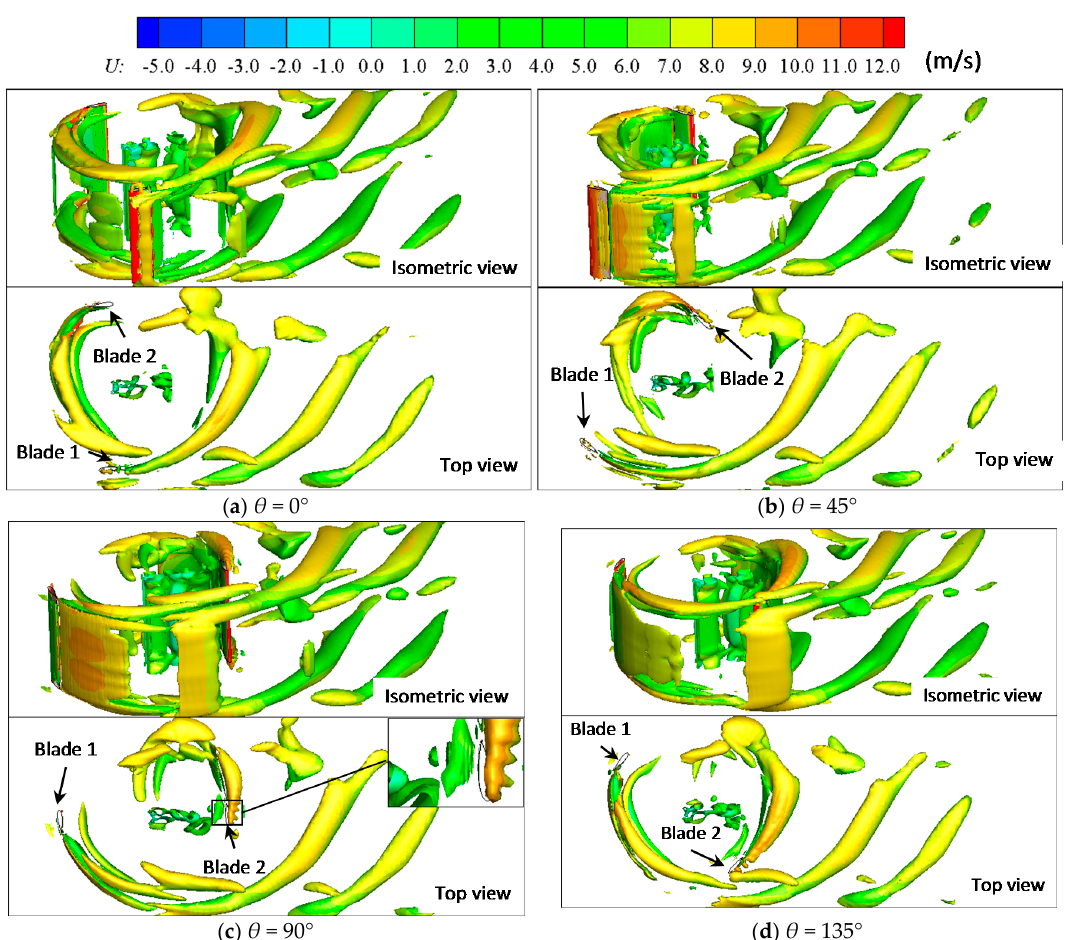
Figure 7. Q -criterion iso-surface of vortex structure for rotor with the azimuth angle of ( a ) θ = 0°, ( b ) θ = 45°, ( c ) θ = 90° and ( d ) θ = 135° at TSR = 2.19. Contour of Q -criterion iso-surface depicts the wind velocity of U .